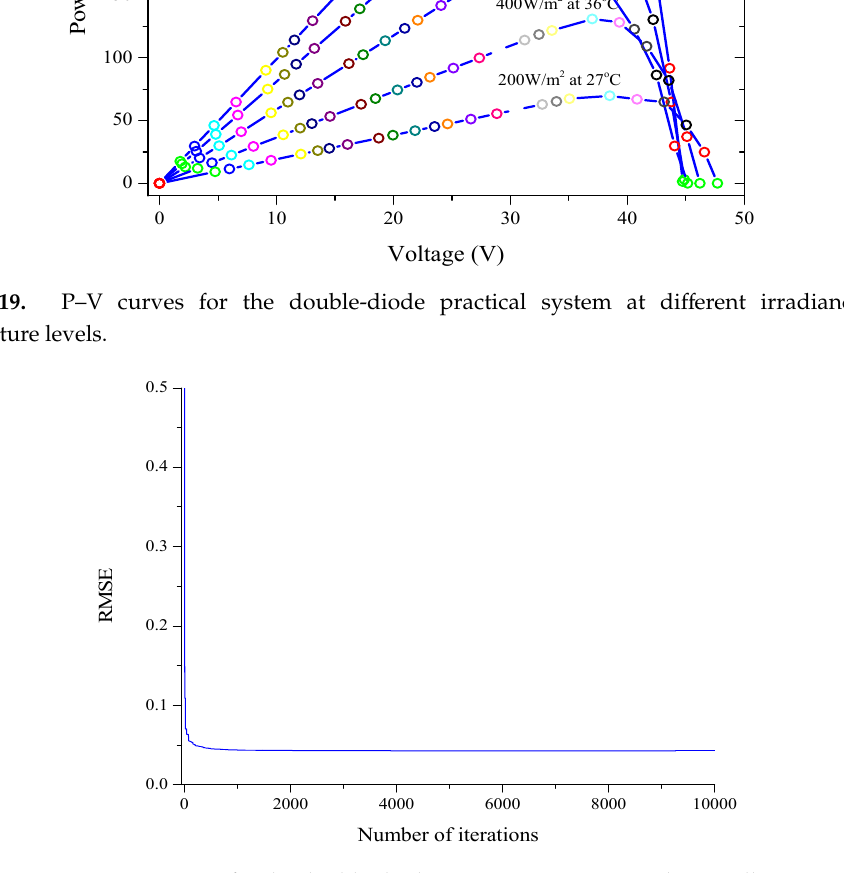
Figure 20. Convergence curve for the double-diode JKM330P-72, 310 W polycrystalline PV